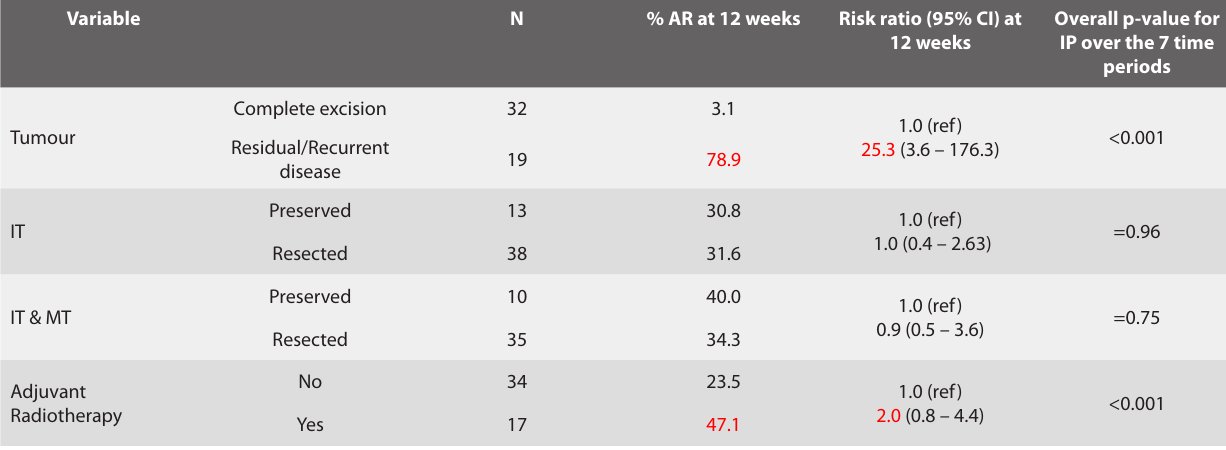
Table 1. Evaluation of relative risk of atrophic rhinitis (12 weeks post – op) and overall p-values.